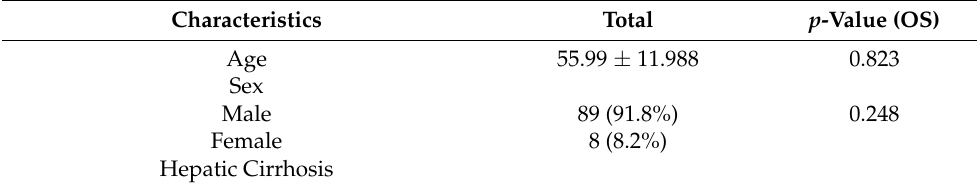
Table 1. Characteristics and univariate analysis of the HHCC cohort (mean SD/N